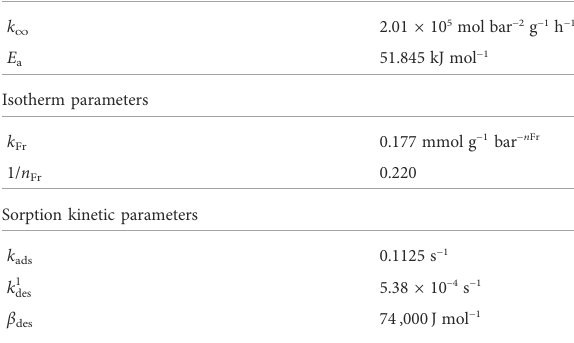
TABLE 3 Kinetic and equilibrium parameters obtained by nonlinear regression from experimental